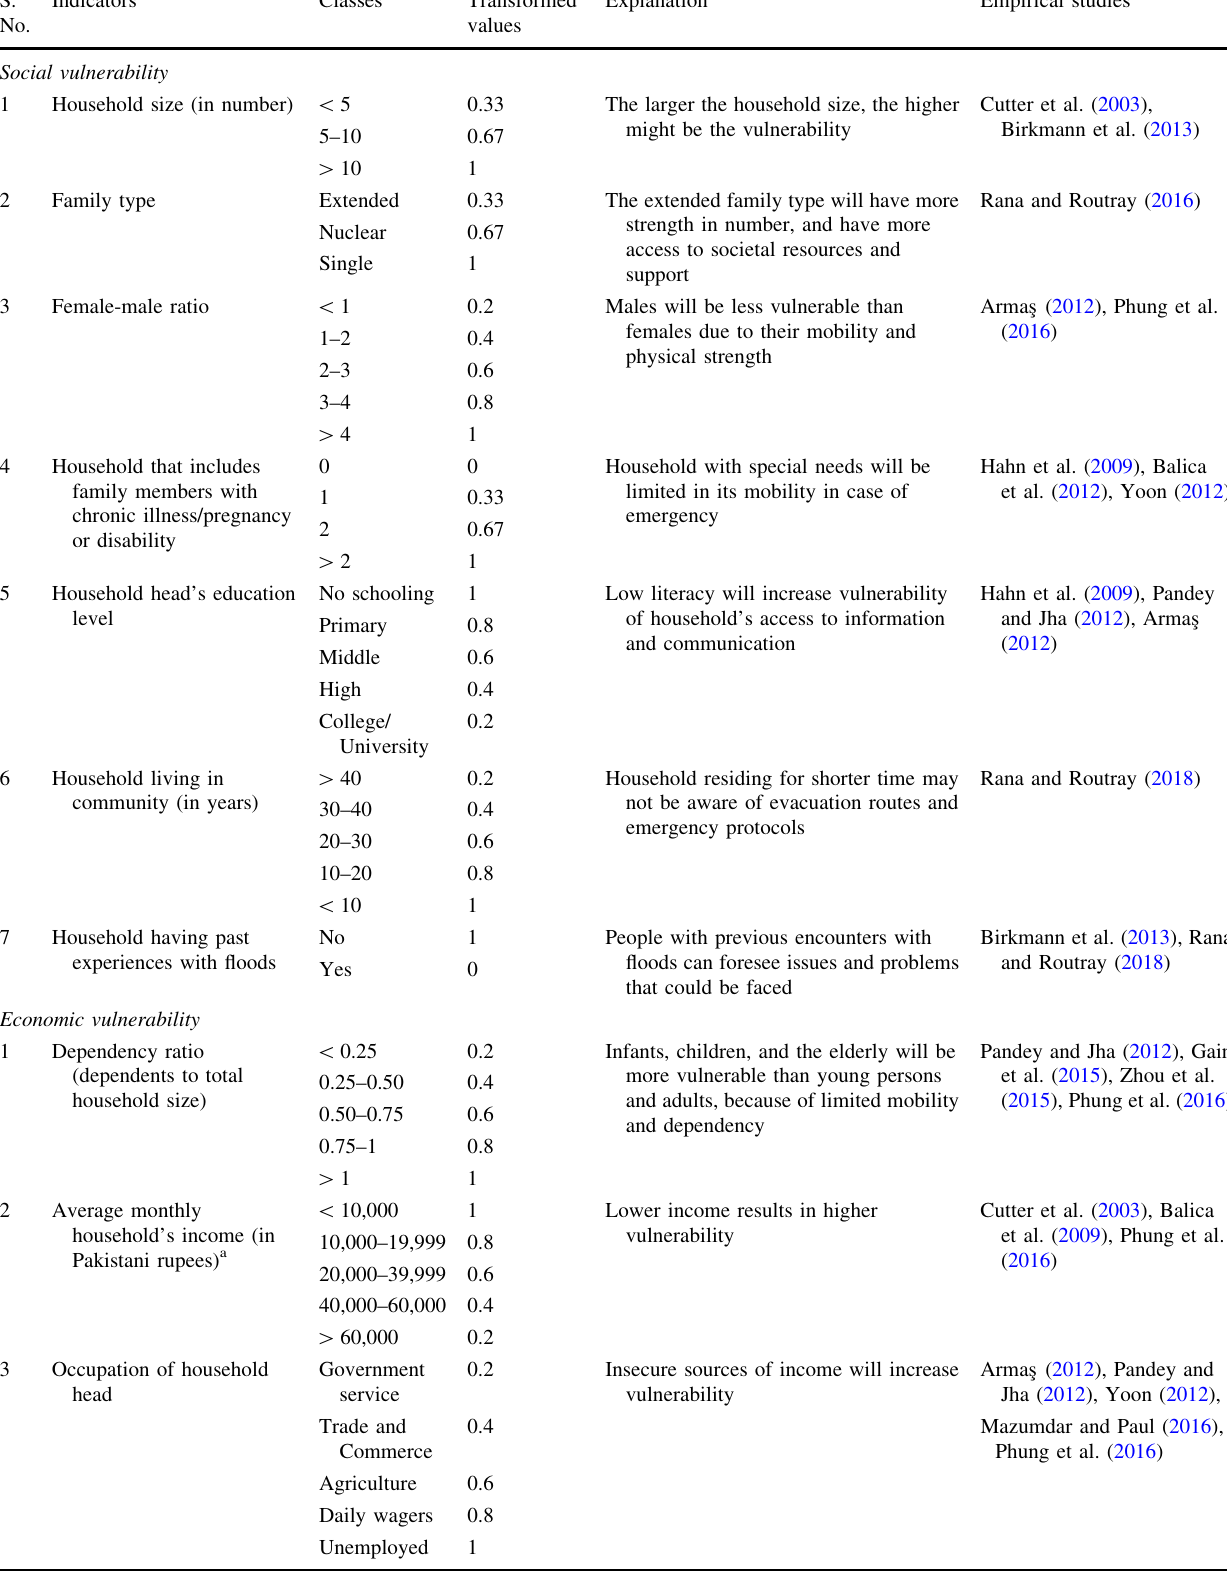
Table 1 Indicators and transformed values for dimensions of vulnerability to urban flooding in Punjab Province, Pakistan S. No.